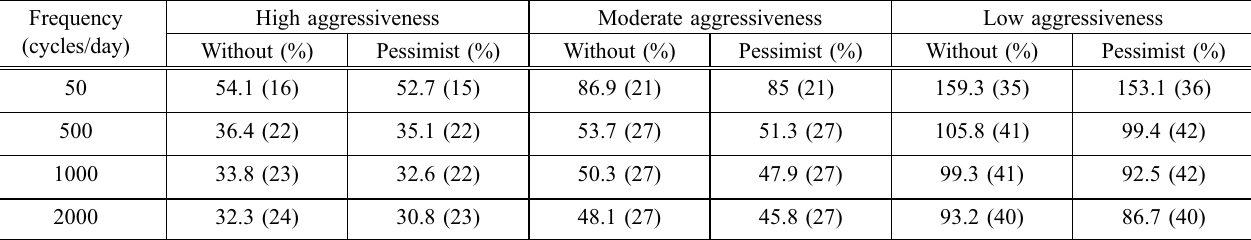
Table 9 Mean (in years) and coefficient of variation (between brackets) of the total lifetime for the oceanic environment. Frequency